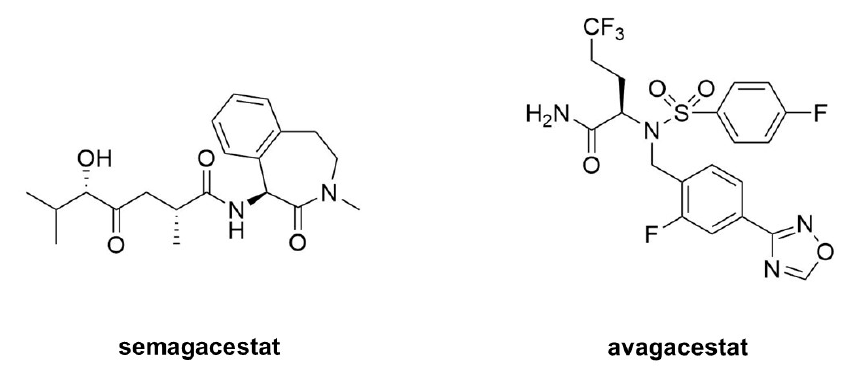
Figure 9. Clinical candidate γ -secretase inhibitors (GSIs). Semagacestat ( left ) is nonselective for APP vis- à -vis Notch, while avagacestat ( right ) is reported as selective for blocking γ -secretase proteolysis of APP over Notch.